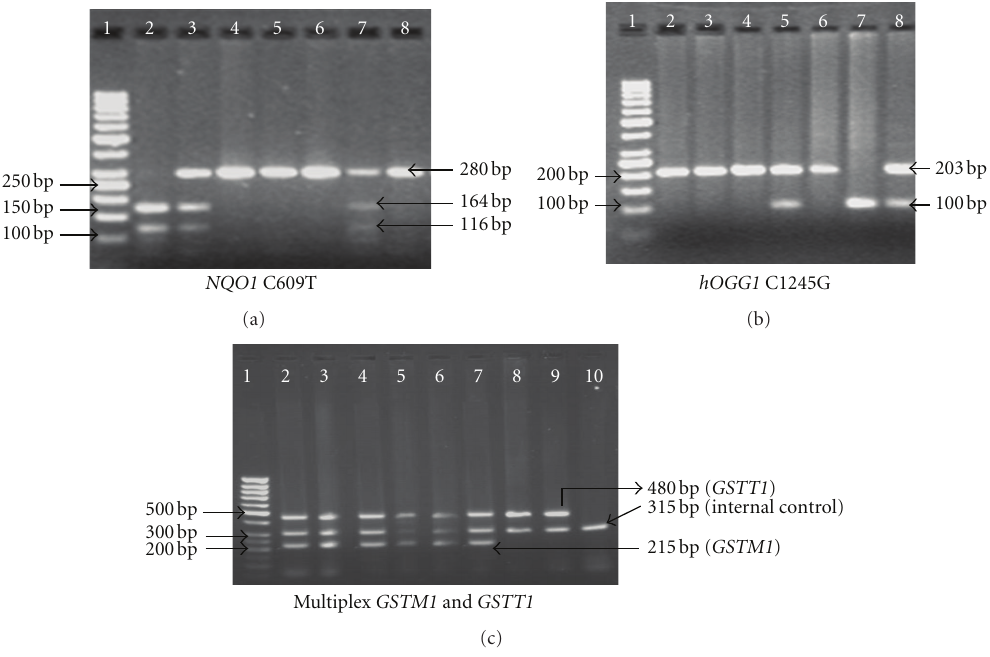
Figure 2: Representative gels of NQO1 C609T, hOGG1 C1245G and multiplex GSTM1 and GSTT1